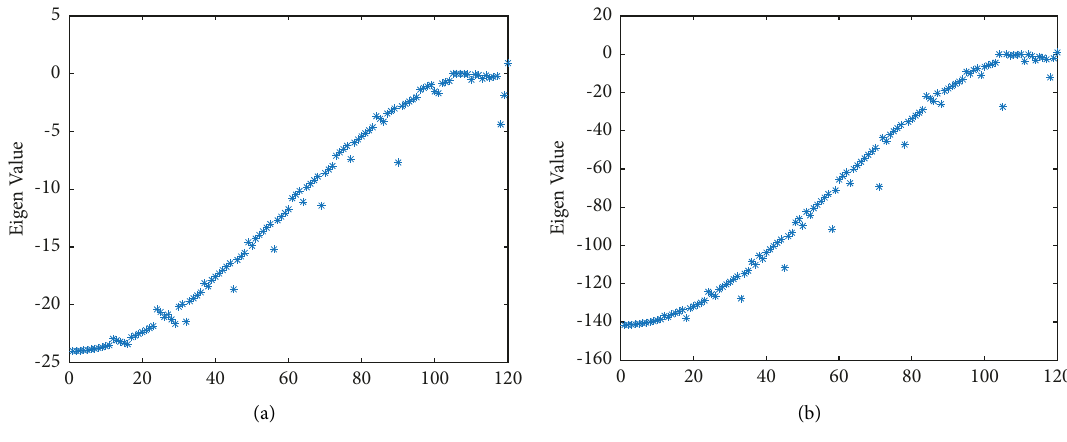
Figure 3: Eigen value profiles for N